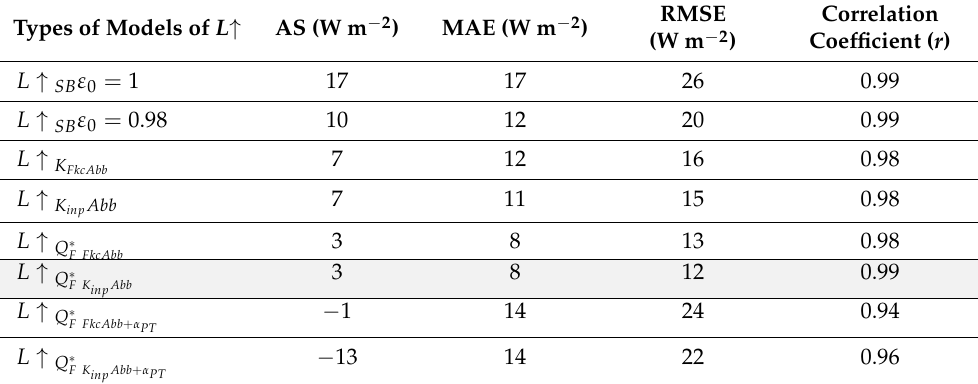
Table 10. Statistical errors and coefficients of correlation for different types of models of L ↑ . (The best model is